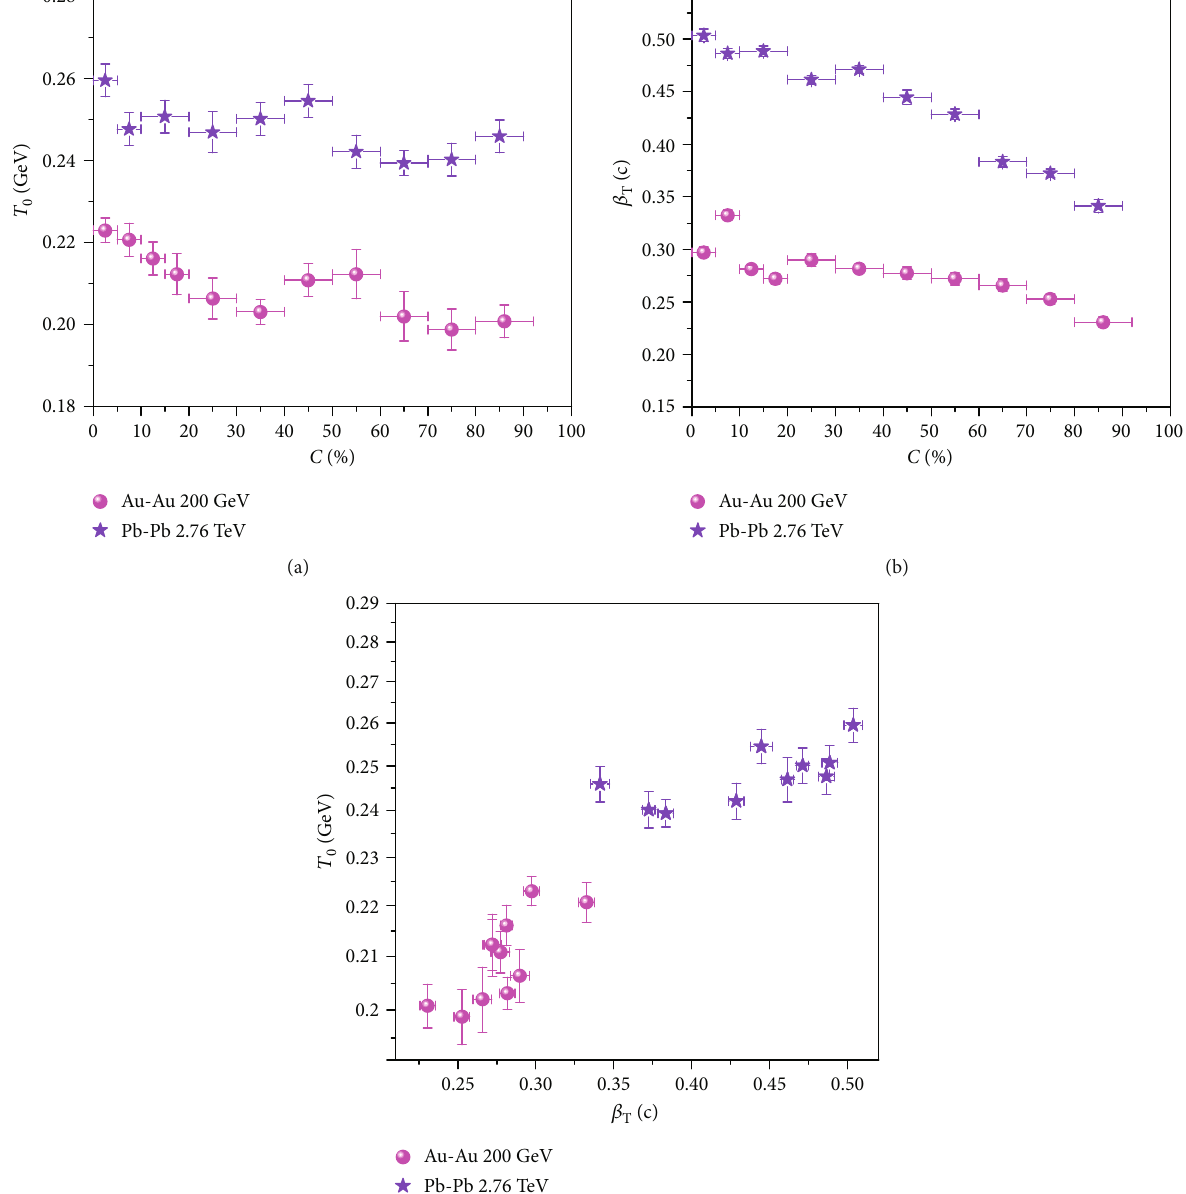
Figure 8: Dependence of (a) kinetic freeze-out temperature T